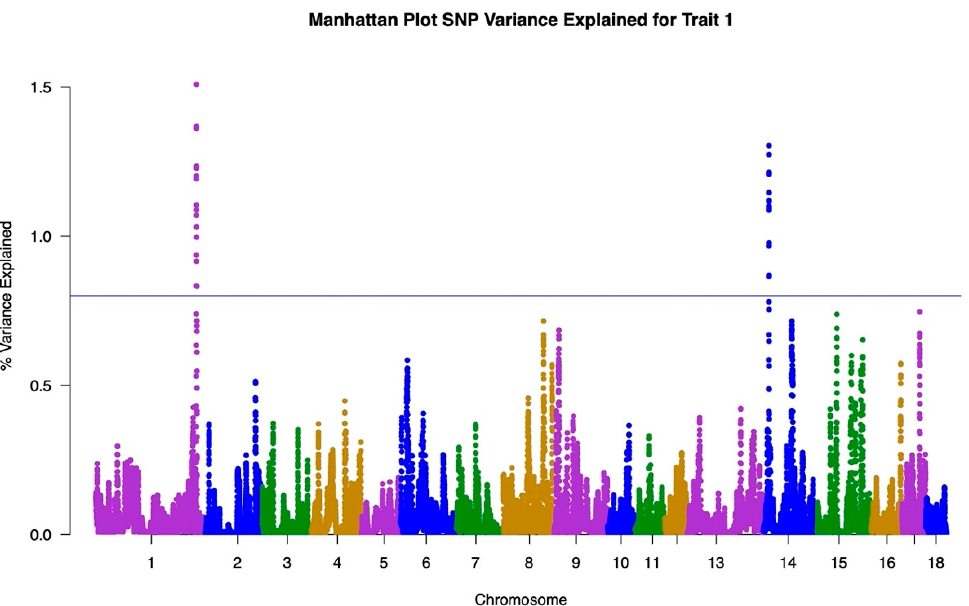
Figure 1. Manhattan Plot representing the Genome-Wide Association Study results for Trait One, referring to HCW under heat stress conditions. Chromosomes listed on x axis and percentage of variance explained listed on the y axis.